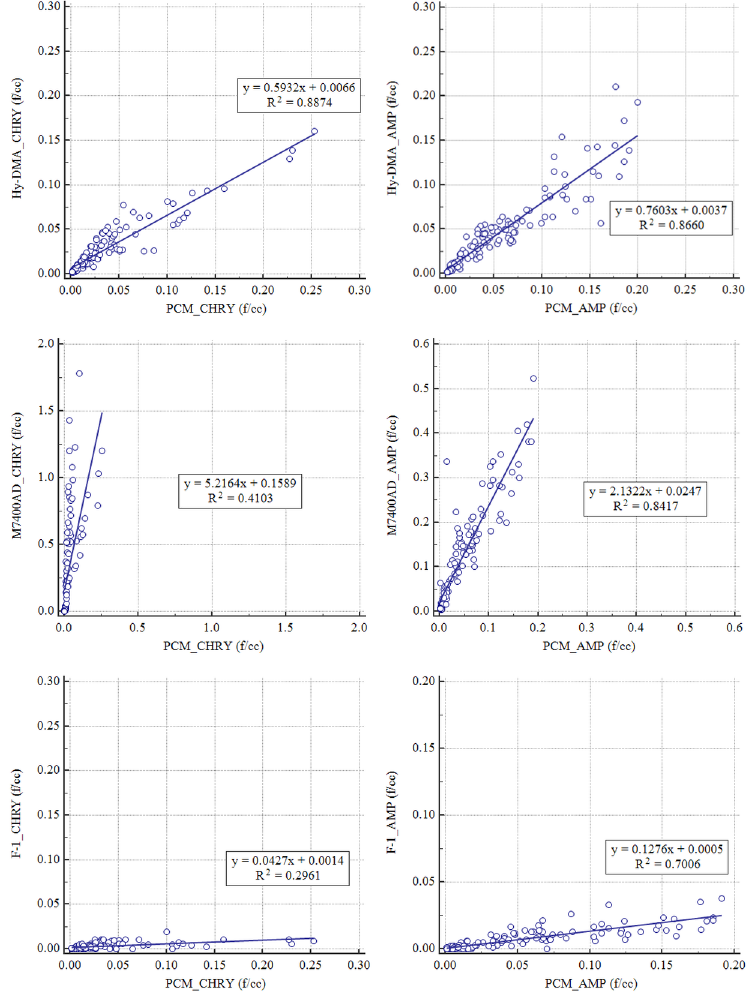
Fig 10. Correlation plots of PCM versus other methods for unknown concentration